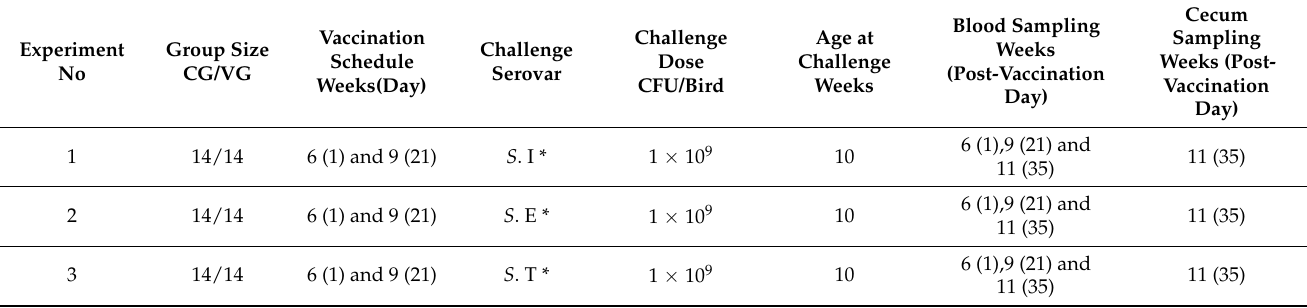
Table 2. Summary of experimental design for each vaccination challenge